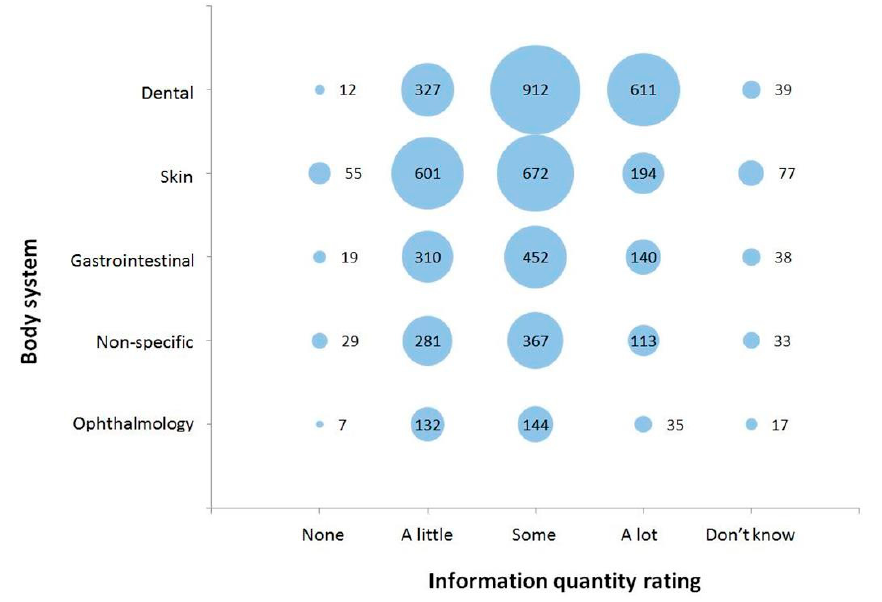
Figure 1. Information quantity rating selected for conditions or complaints affecting the five most commonly categorised body systems in rabbits ( n = 6324) from a survey of UK veterinarians. Size of the bubble, and the data label within or to the right of each bubble, corresponds to the total number of conditions or complaints fitting into each combination of body system category and information quantity rating.